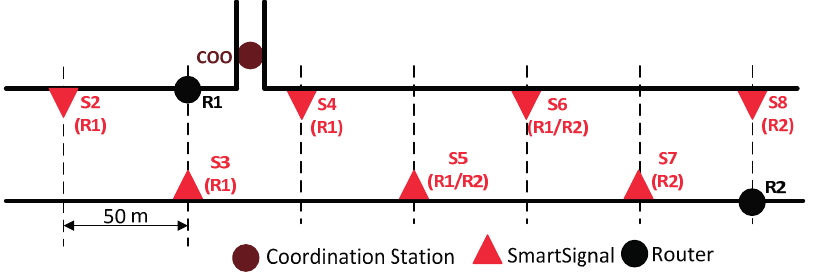
Figure 12. Details of setup around coordination station (scenario to test the